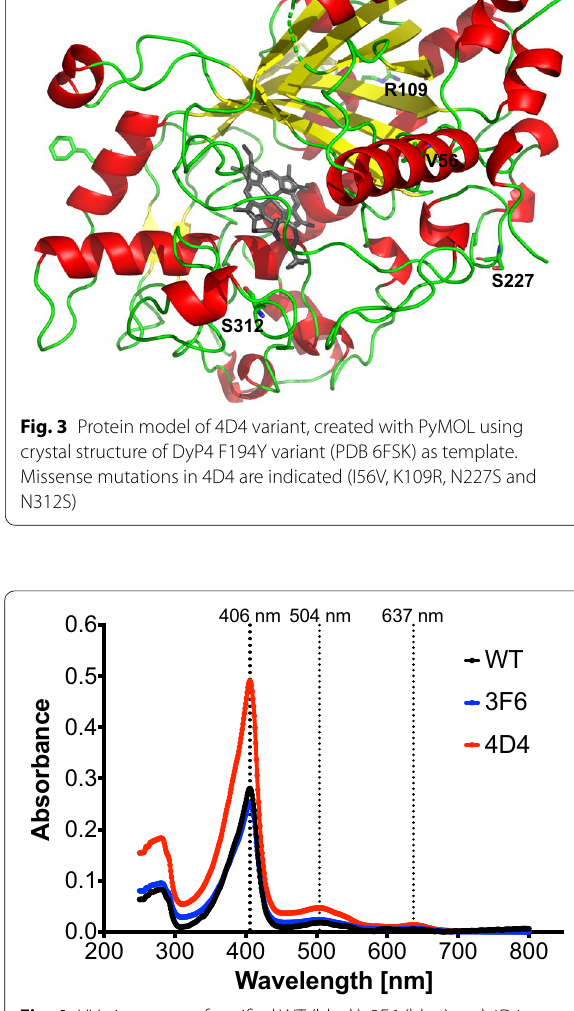
file 1: Figure S9). After protein purification, all 3 purified proteins exhibited a distinctive Soret band at 406 nm with a slight shoulder at ~ 385 nm (Fig. 4). Q band at 504 nm and a charge-transfer (CT) band at 637 nm were also clearly visible.